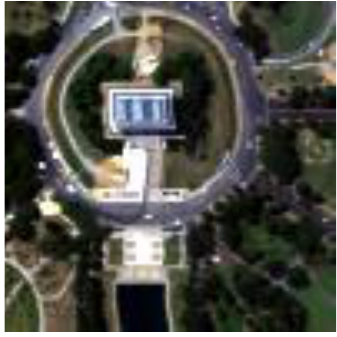
Figure 17. Sub-region of Hyperspectral Digital Imagery Collection Experiment (HYDICE) data.